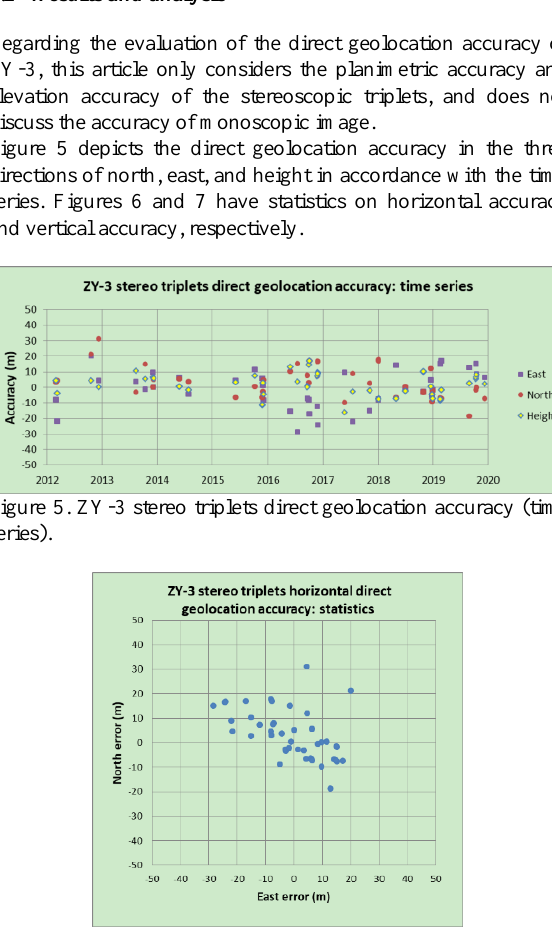
Figure 6. ZY-3 stereo triplets horizontal direct geolocation accuracy (statistics). Num=47 stereo triplets; Average(East)=- 1.116m; Average(North)=3.400m; RMS(North)=10.438m; RMS(Horizontal)=16.232m.